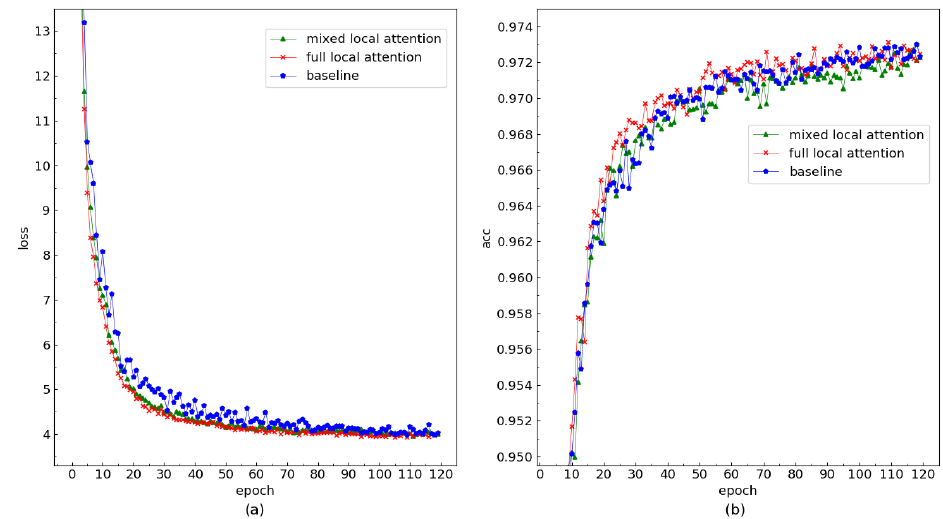
Figure 5. ( a ) Loss curve with dev-other. ( b ) Accuracy curve with dev-other.